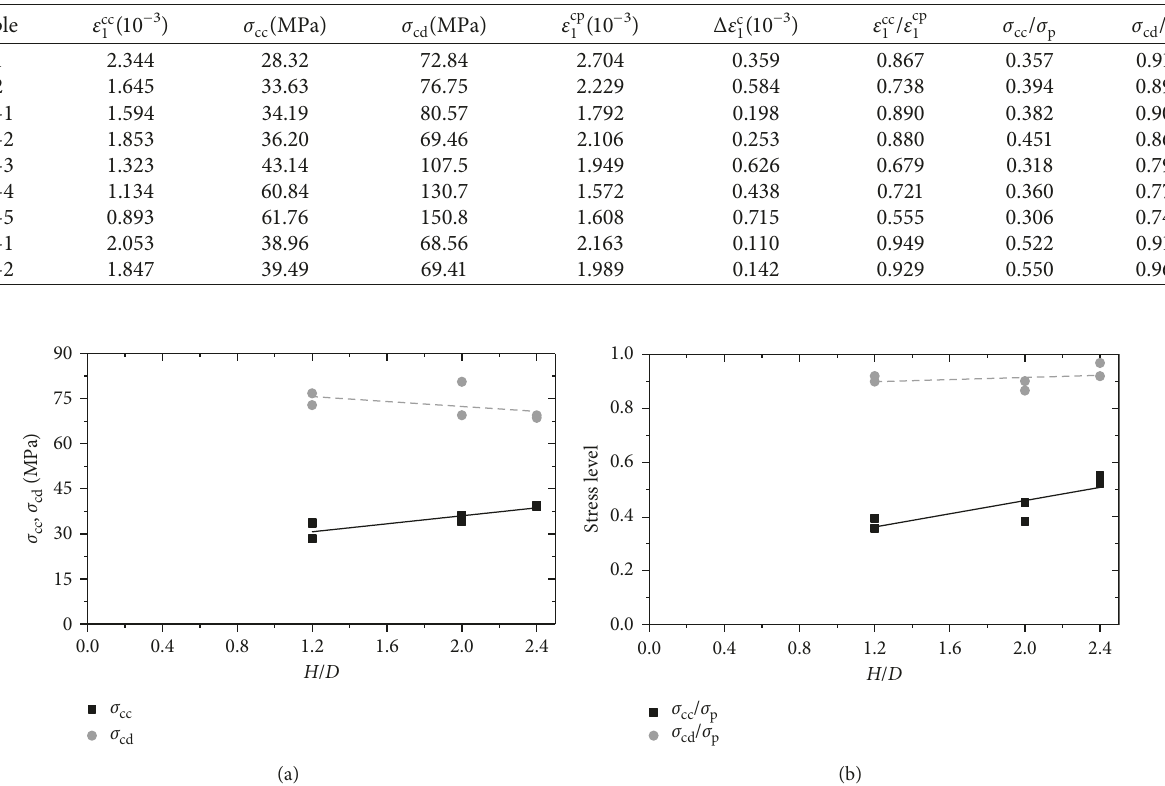
Figure 5: (a) Relationship between the crack closures and damage stresses and the H / D ; (b) relationship between the stress levels and the H / D